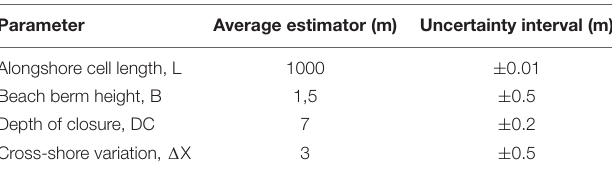
TABLE 3 | Typical variation intervals for the geometric parameters defining control cell volume ( Figure 6 ) in Spanish Mediterranean sandy beaches, adapted from Gracia (2005) and CIIRC (2010).